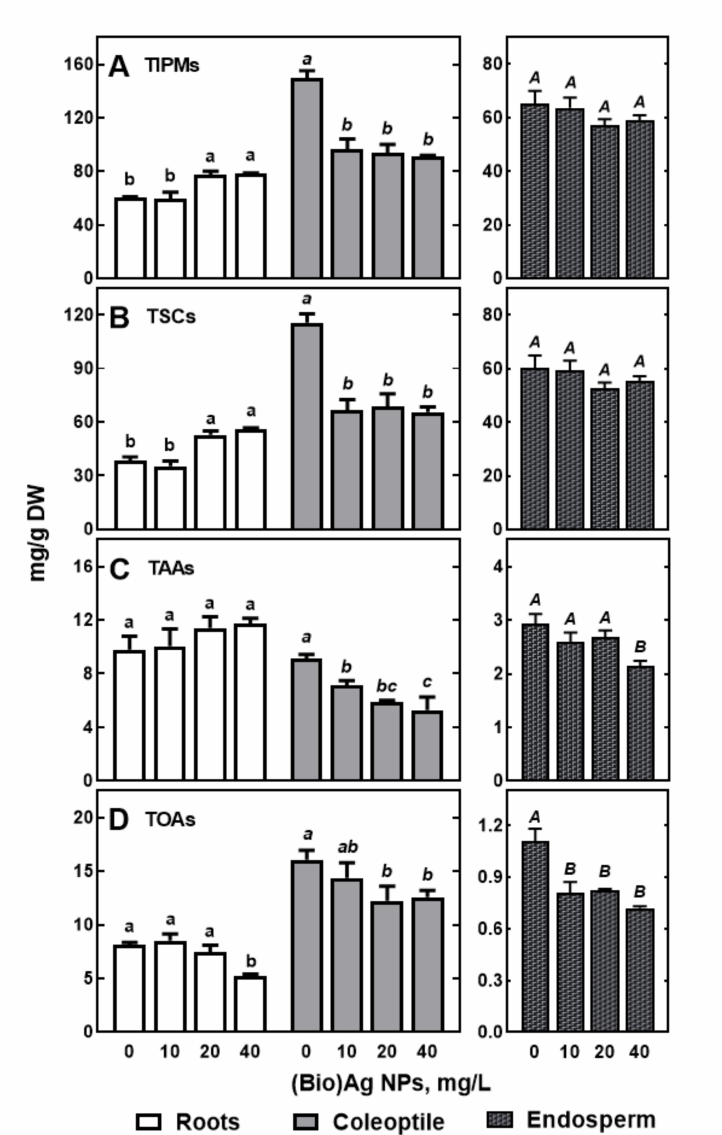
Figure 6. The effect of (Bio)Ag NPs on the concentration of total identified polar metabolites (( A ), TIPMs), including total soluble carbohydrates (( B ), TSCs), total amino acids (( C ), TAAs), and total organic acids (( D ), TOAs) in roots, coleoptile, and endosperm of 3-days-old seedlings of wheat ( Triticum aestivum L. cv. ‘Ostka Strzelecka’). Control grains germinated in dd. water. Values are means ( n = 3) ± SD. Bars with the same letters (a–b, a–c , A–B ) are not significantly ( p < 0.05) different after the ANOVA test and Tukey’s post hoc